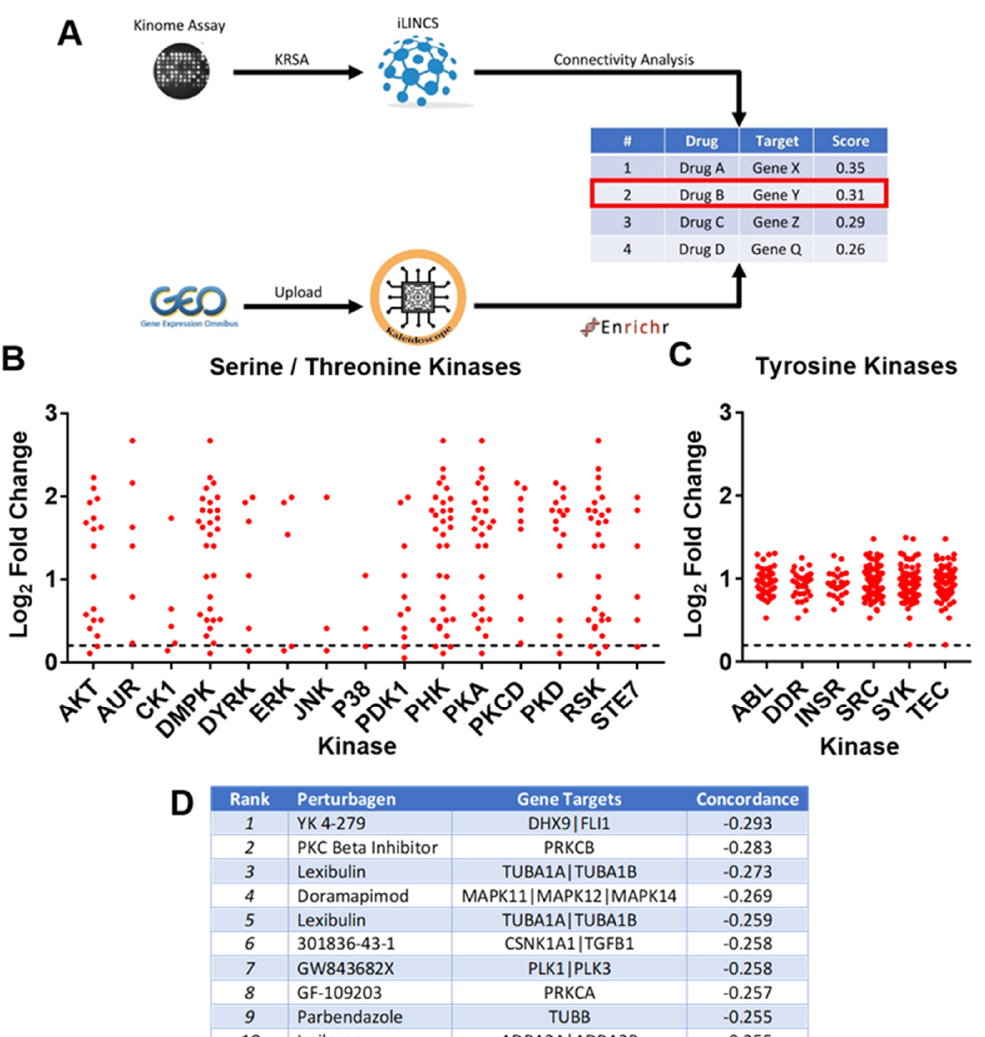
Figure 4. Kinome profiling and in silico workflow for the identification of MC-LR-induced kinase activity and potential inhibitory compounds. ( A ) Schematic summarizing the overall workflow. Gene expression profiles derived from kinome profiles and published MC-LR exposure gene expression profiles were compared against perturbagen signatures in iLINCS to generate a list of hypothetical inhibitory compounds for the MC-LR-induced kinase activity. ( B ) Kinase activity from the serine/threonine kinase (STK) ( C ) and tyrosine kinase (PTK) arrays. ( D ) Identified hypothetical inhibitory compounds ranked by their inverse concordance with the MC-LR-induced